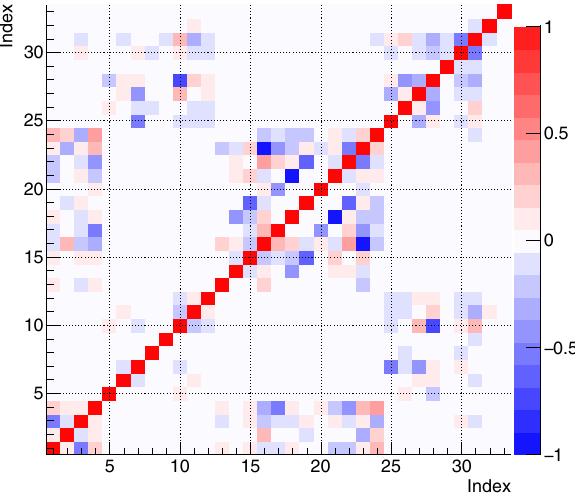
Fig. 8 Correlation matrix among the reconstructed activities. The source indexes are from Table 4